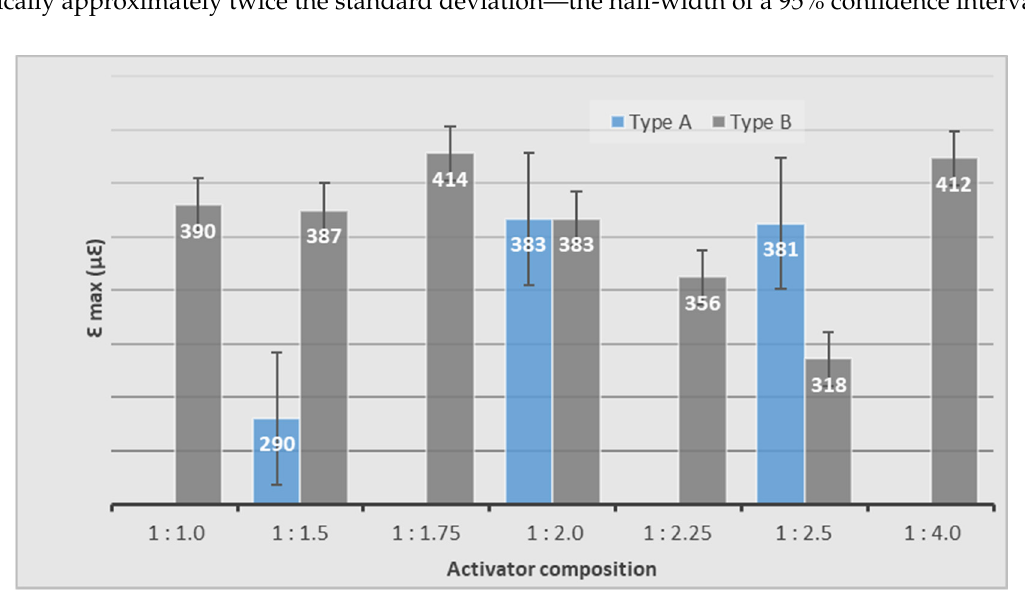
Figure 3. Strains at failure for Type A and Type B mixes.